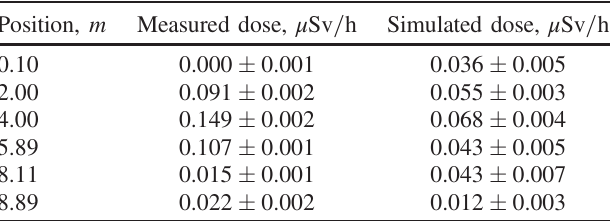
TABLE I. The comparison between measured and simulated dose rates at different positions. Positions are given with respect to BOA roof. The error bars represent the standard errors.